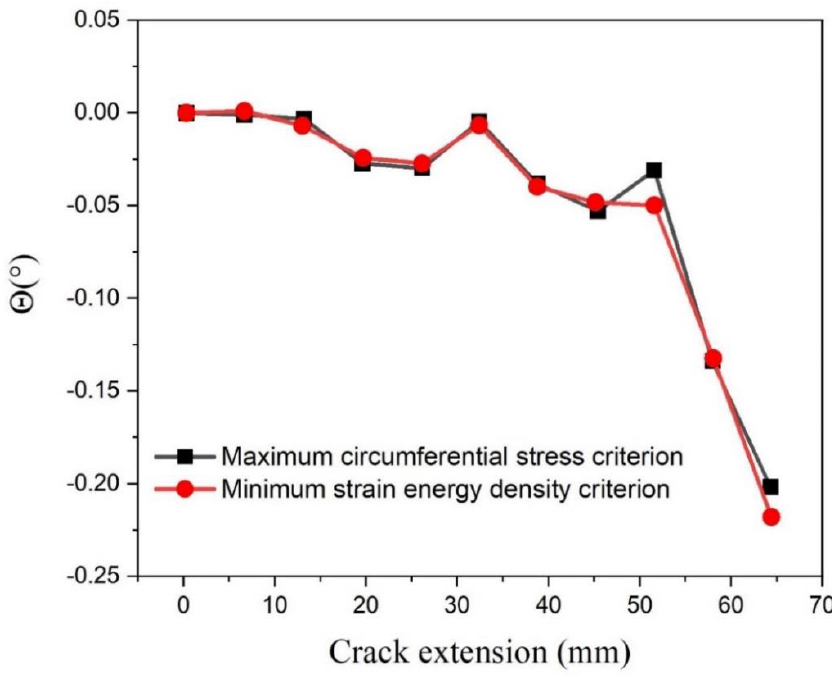
Figure 7. Evolution of kinking angle θ during crack propagation, comparison between the MCS and MSED criterion.